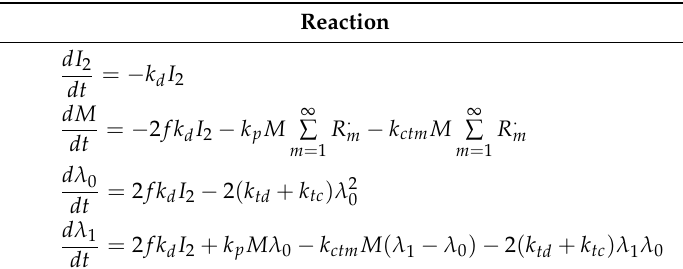
Table 2. Population balance equations on the involved species I 2 , M and the zero and first order moments of the active chain distribution, λ 0 and λ 1